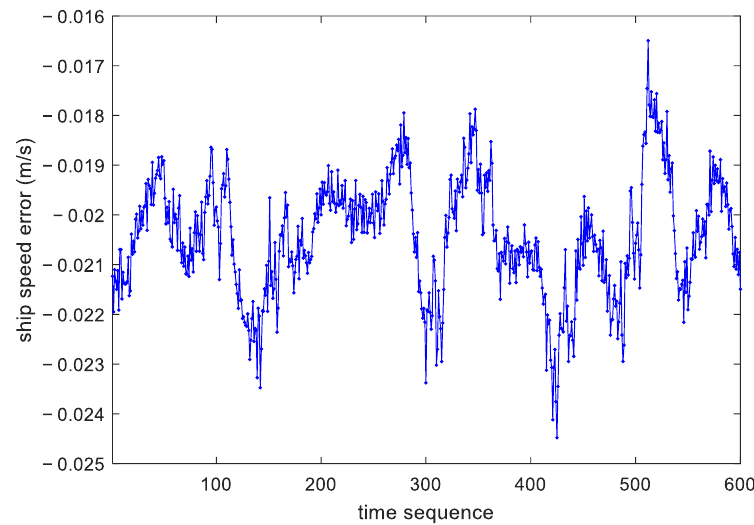
Figure 6. Prediction results of ship speed.